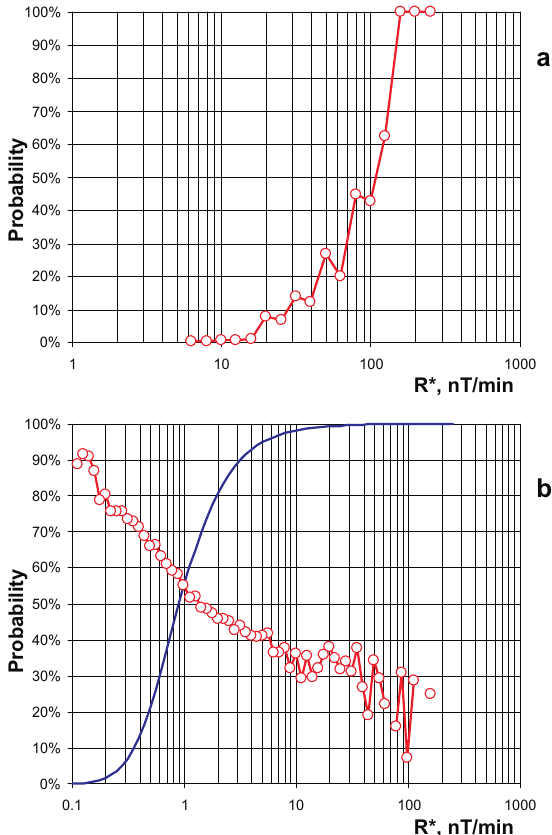
Fig. 11. Conditional probabilities for PAF (hourly varia- tion R ∗ computed from minute values): (a) P (R ∗ (k + 1 ) > 50nT/min | R ∗ (k)) ; (b) P (R ∗ (k + 1 ) > R ∗ (k) | R ∗ (k)) , and the em- pirical distribution of R ∗ (blue line), i.e. unconditional probability P (R ∗ (k + 1 ) ≤ R ∗ )